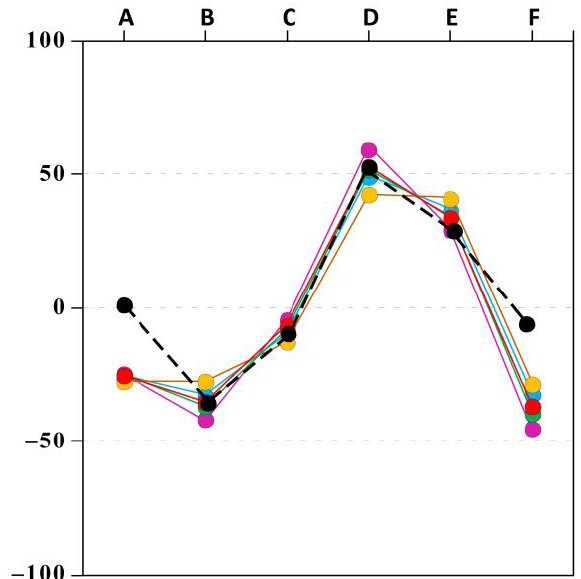
Figure 8. Application of the IIRG method [34] to the thermal waters of Goutitir; (symbols as in Figure 4 and the reference pattern is black).